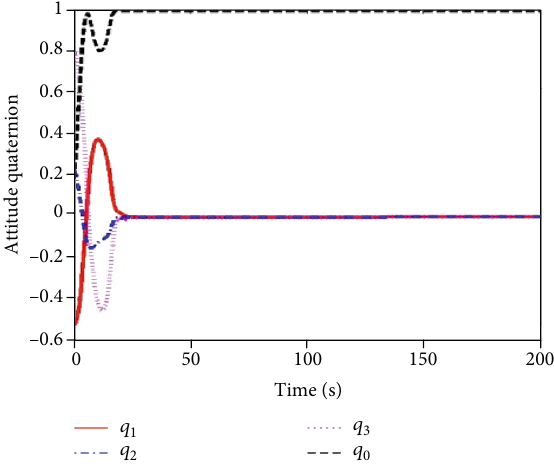
Figure 10: Time histories of attitude quaternions in Case 2.